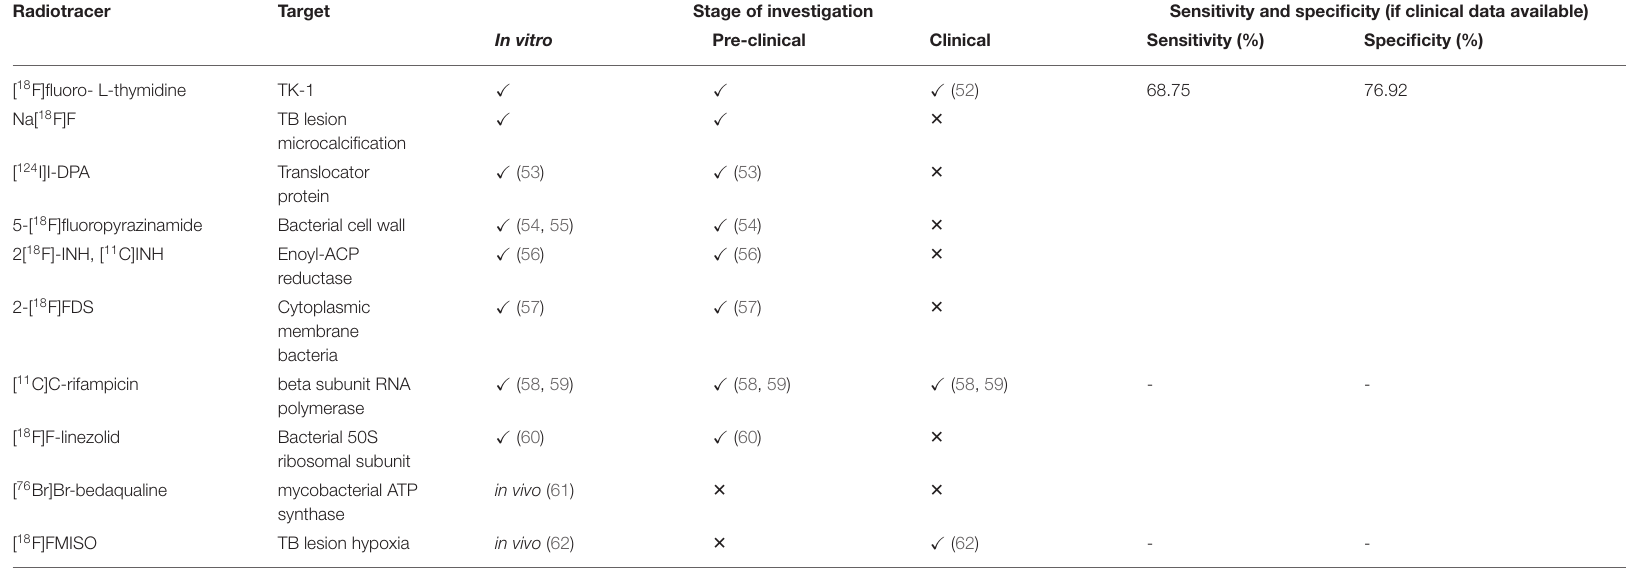
X : Indicates work that has been performed in the respective domain. 5 : Indicates work that has not been performed in the respective domain. -: Indicates data